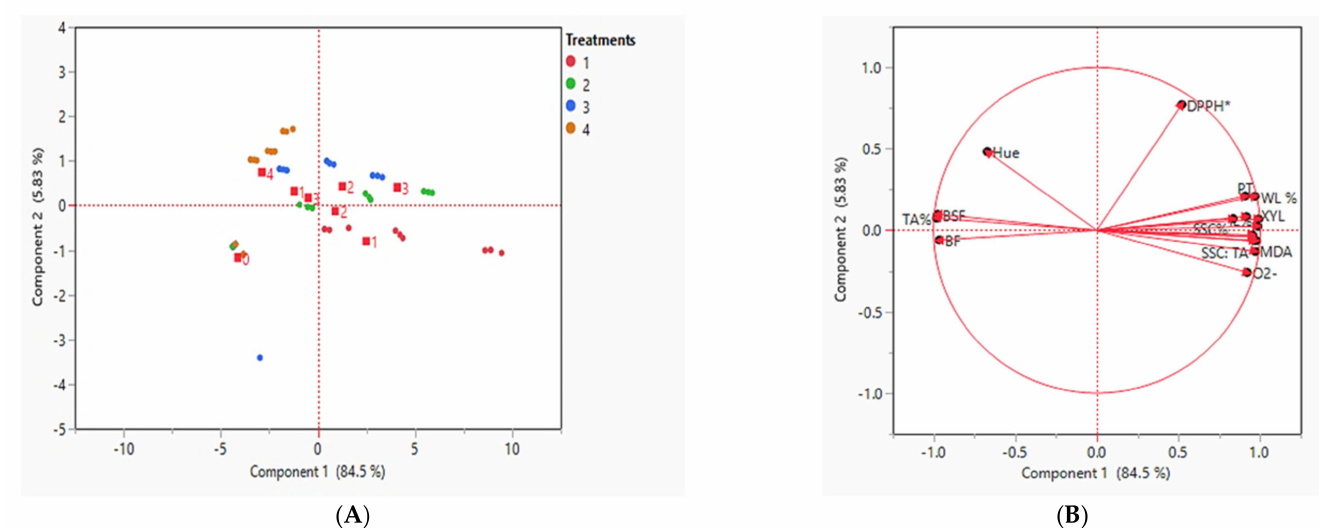
Figure 9. Exhibits principal component analysis (PCA) representing pectin blended with PVA supported with salicylic acid relative to ‘Crimson Seedless’ grape during shelf-life period, outlined with the contribution of each parameter on the two PCA axes ( A ) and all parameters measured in bunches during shelf-life duration ( B ). Principal component analysis (PCA)–variable correlation. The numbers (1–4) represent coating treatments: untreated bunches; PE + PVA-SA 0 mM , PE + PVA-SA 1 mM , and PE + PVA-SA 2 mM